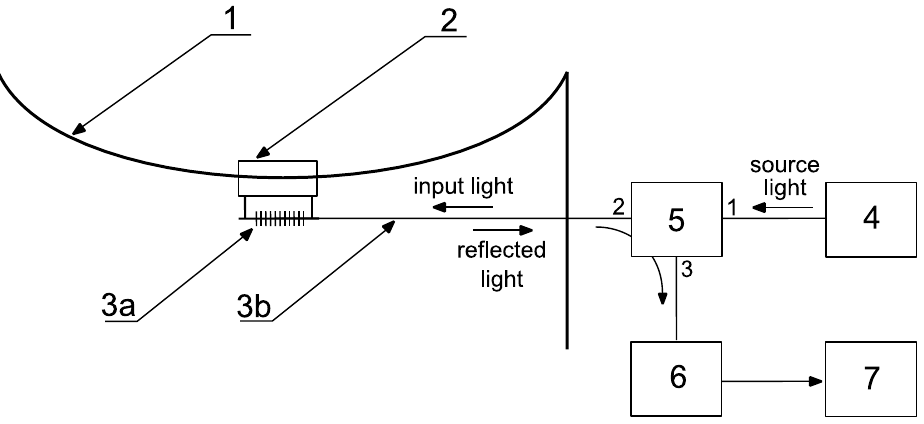
Figure 1. The overhead transmission line wire sag measurement system where: 1: the ACSR 26/7 Hawk conductor; 2: the measuring clamps/sensing head; 3a: the optical fiber; 3b: the inscribed chirped fiber Bragg grating; 4: the light source with a stabilized super-luminescent diode; 5: the optical circulator; 6: the optical spectrum analyzer; and 7: the computer/gateway.